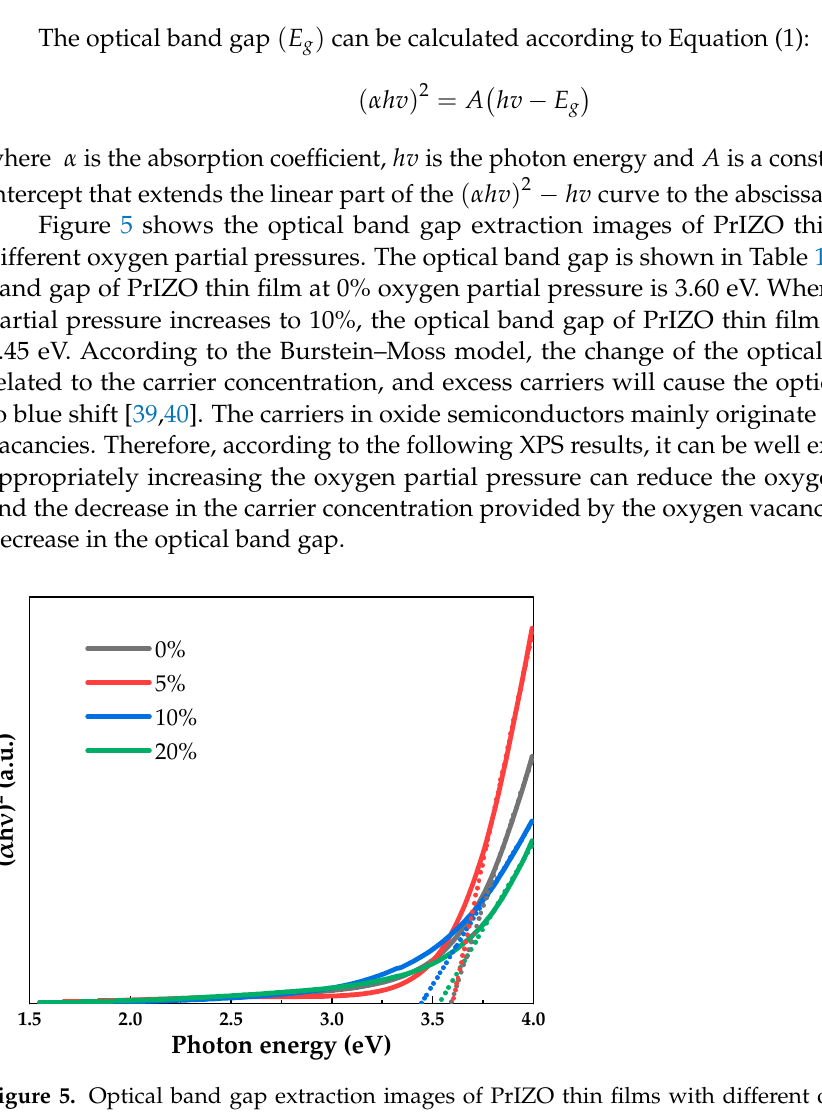
Figure 5. Optical band gap extraction images of PrIZO thin films with different oxygen partial pres- sures.